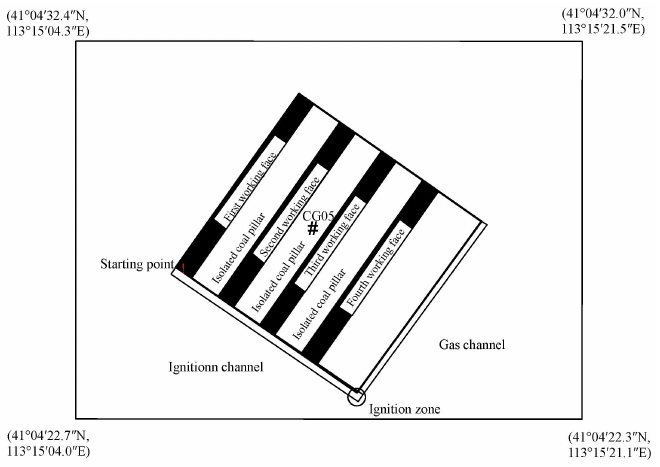
Figure 1. Layout of the UCG working